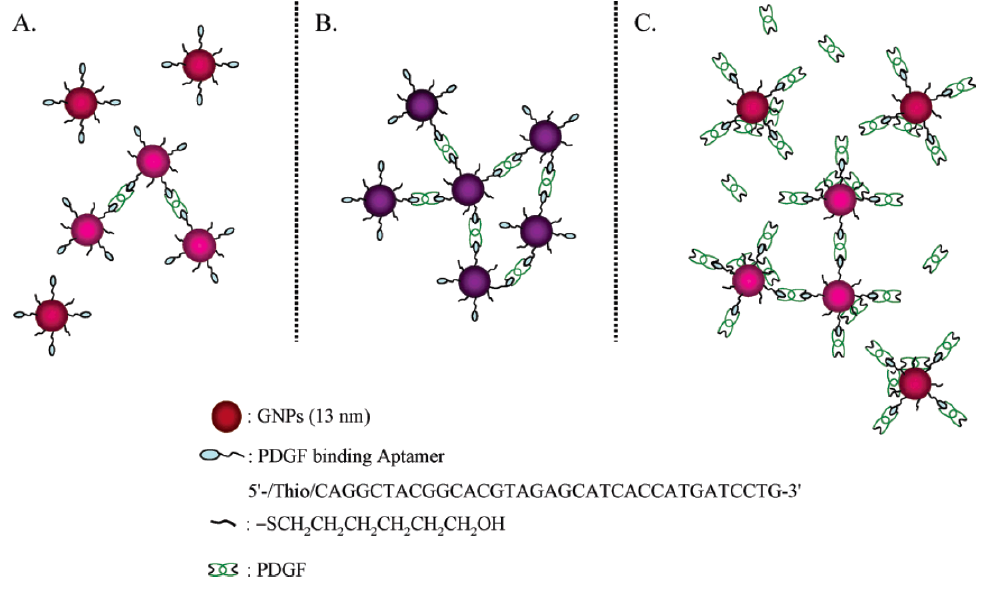
Figure 8. Schematic representation of the aggregation of Apt-Au NPs in the presence of PDGFs at (a) low, (b) medium, and (c) high concentrations. Reprinted with permission from Reference